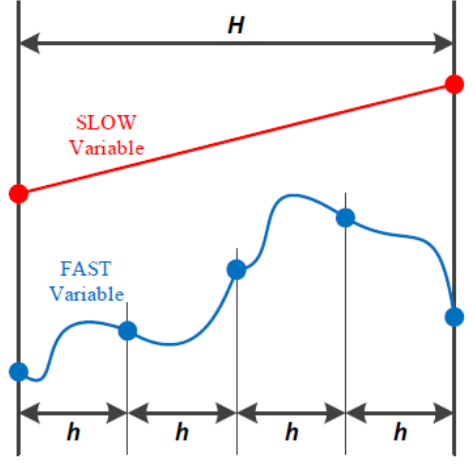
Figure 2. Multi-rate